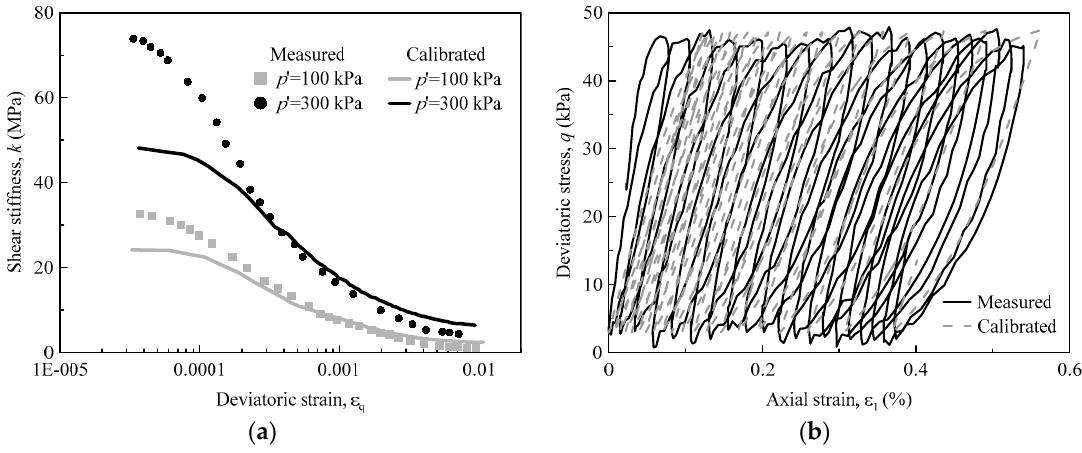
Figure 3. Comparison between measured and computed of: ( a ) small-strain stiffness; ( b ) stress-strain relationship of soil element subjected to cyclic triaxial shearing. Table 1. Hypoplastic clay model parameters of kaolin clay.